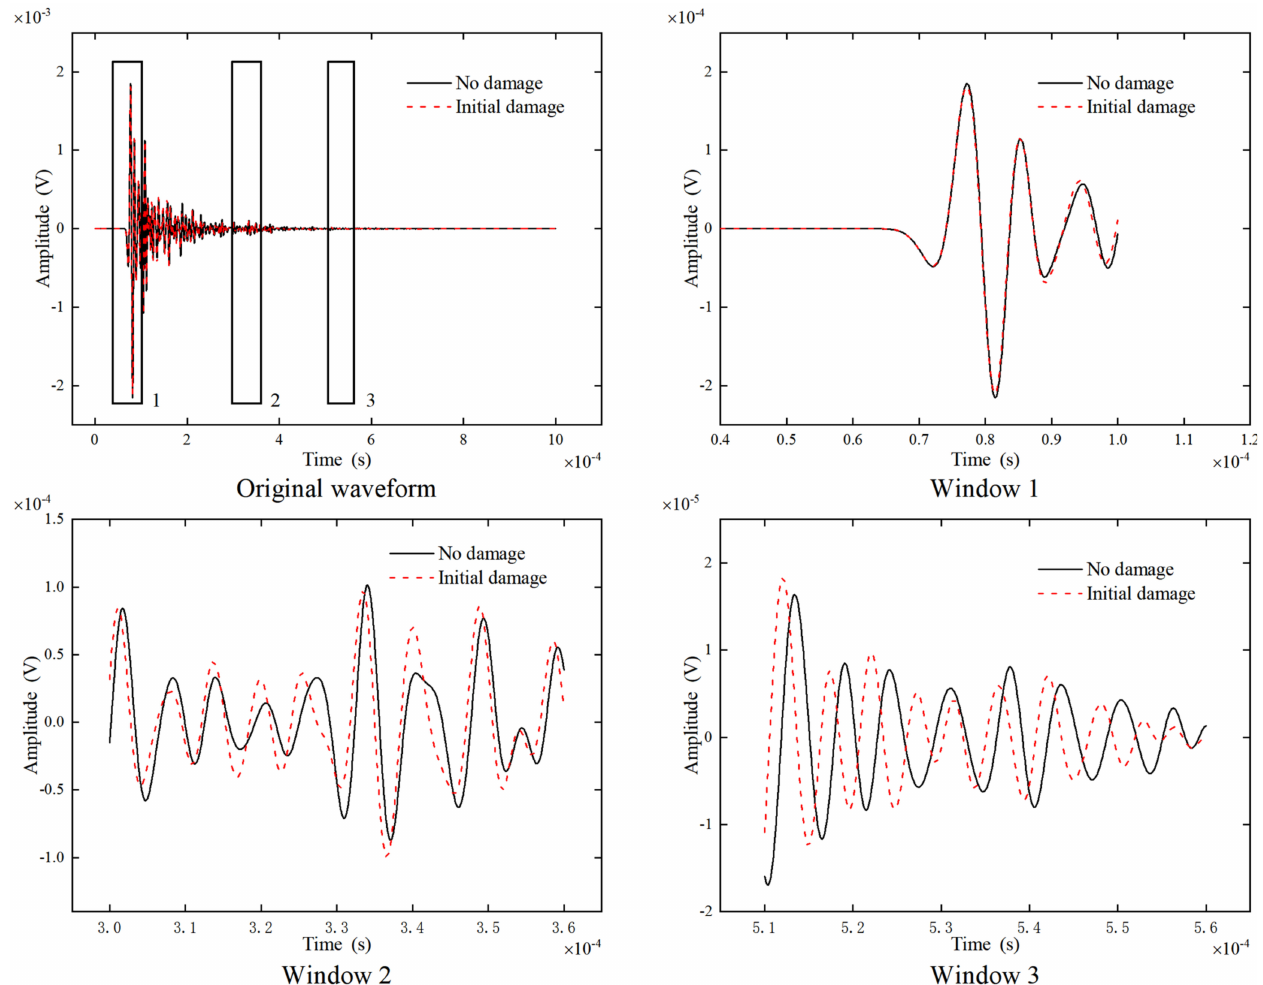
Figure 15. Comparison of the ultrasonic receiving waveform before and after